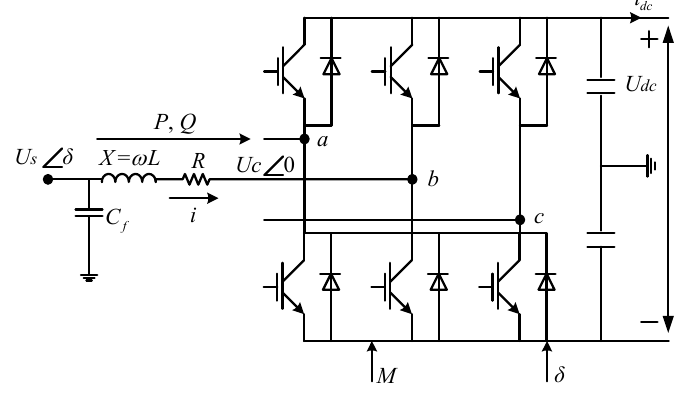
Figure 2. Main circuit topology diagram of voltage source